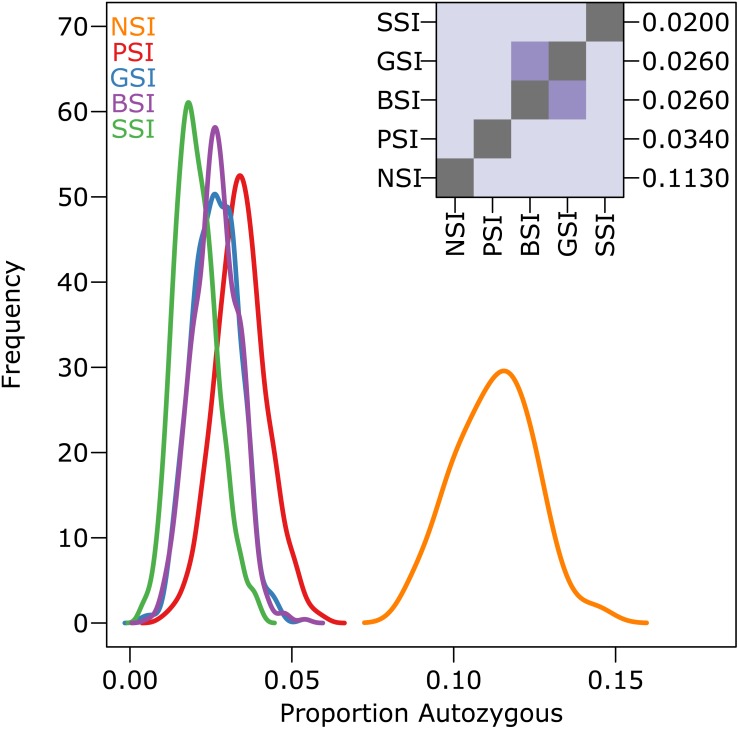
The reduction in biparental inbreeding in homomorphic SI systems was small compared to the reduction in self-fertilization.The empirical density plot (main) shows the distribution of the proportion of autozygotes in 500 samples from simulations of each SI system. The inset shows the pairwise comparisons of each distribution where the color of each square indicates the outcome of a Holm-corrected, pairwise Anderson–Darling test which determined whether the pair of distributions were significantly different (p < 0.05; light color) or not (dark color). The values along the right axis of the inset are the medians in increasing order. The simulations included inbreeding depression and were run on a 100 ×100 landscape with pollen and seed dispersal parameter σ = 1.